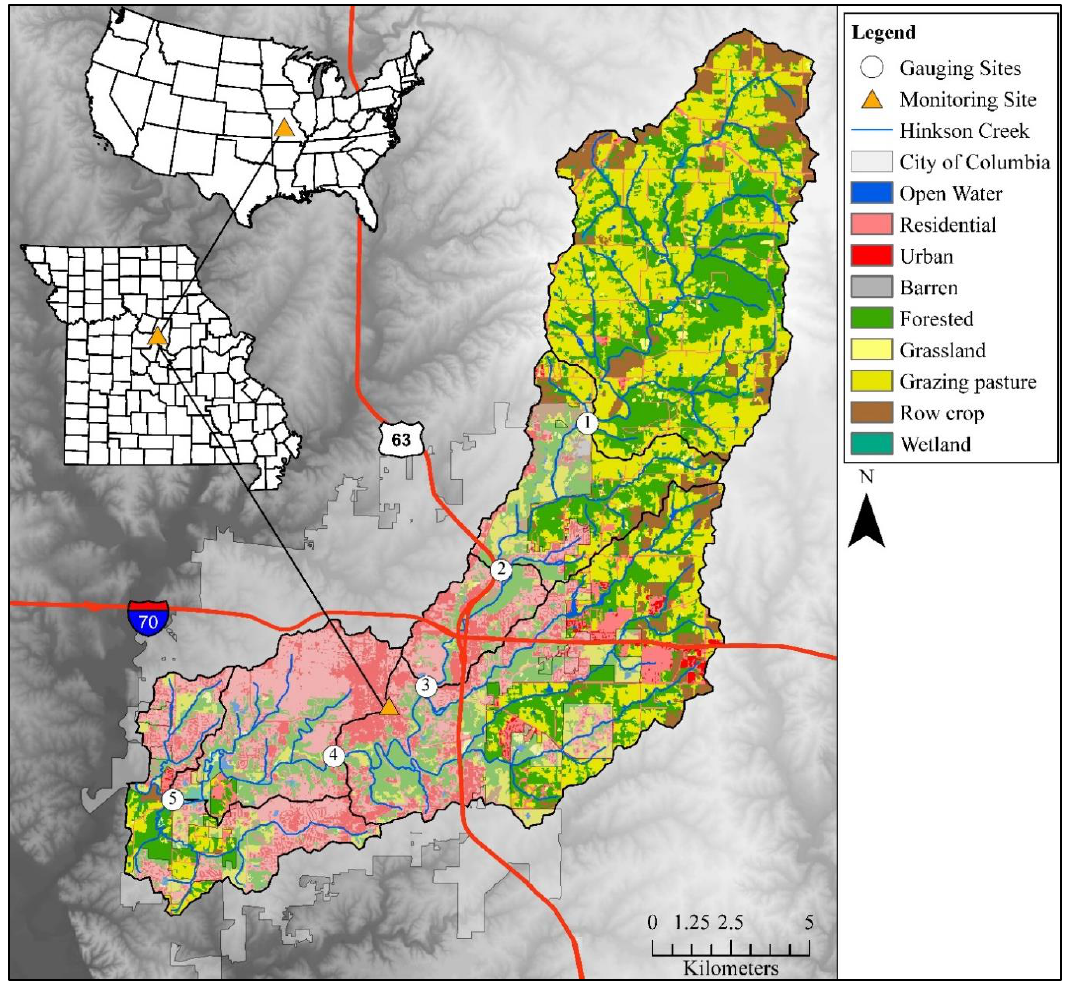
Figure 1. Nested-scale experimental watershed study design, including five gauging sites located in Hinkson Creek watershed, MO, USA. The 2011 National Land Cover Dataset (NLCD 2011) was used to calculate the land use and land cover shown.